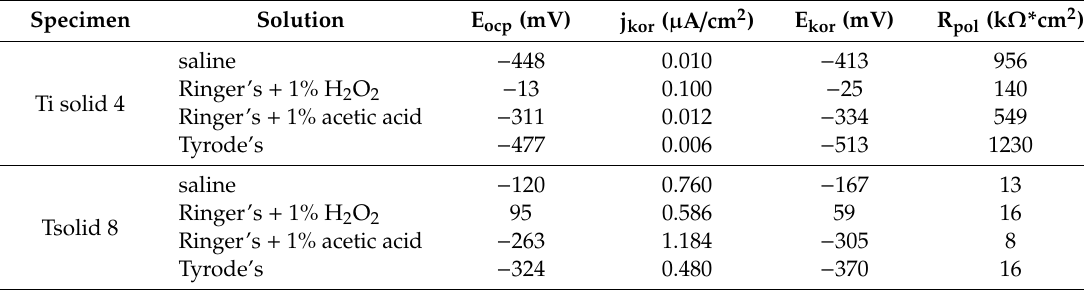
Table 6. Tafel’s analysis results of tested